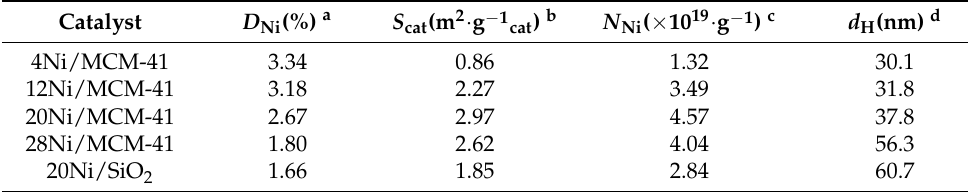
Figure 6. H 2 -TPR profiles of calcined x Ni/MCM-41 and 20Ni/SiO 2 catalysts. Figure 6. H -TPR profiles of calcined x Ni/MCM-41 and 20Ni/SiO 2 An H 2 chemisorption measurement was conducted to determine the Ni dispersion, metal surface area, number of active Ni atoms and average particle size of Ni. All results were estimated by assuming that one hydrogen atom is adsorbed on one active nickel atom [30,31]. Table 2 shows the H 2 chemisorption results for the reduced x Ni/MCM- 41 and 20Ni/SiO 2 catalysts. Obviously, the Ni dispersion of the x Ni/MCM-41 catalysts gradually decreased as the Ni content rose, while the average particle diameter of Ni increased. The results indicate that the active Ni were highly dispersed with small particle size at low Ni contents. The metal surface area and active metallic Ni atom numbers of the catalysts firstly increased and then slightly decreased, indicating that there was an optimum threshold value of Ni content on the MCM-41 support. The 20Ni/SiO 2 catalyst shows the Ni dispersion of 1.66% and the values of metal surface area and active metallic Ni atom numbers were all lower than those of 20Ni/MCM-41 catalyst. Among the catalysts tested, the 20Ni/MCM-41 catalyst with a Ni content of 20 wt% shows the highest metal surface area (2.97 m 2 · g − 1 cat ) and active metallic Ni atom numbers (4.57 × 10 19 g − 1 ), which is probably responsible for the high catalytic methanation activity [32]. Table 2. H 2 chemisorption results of the reduced x Ni/MCM-41 catalysts.